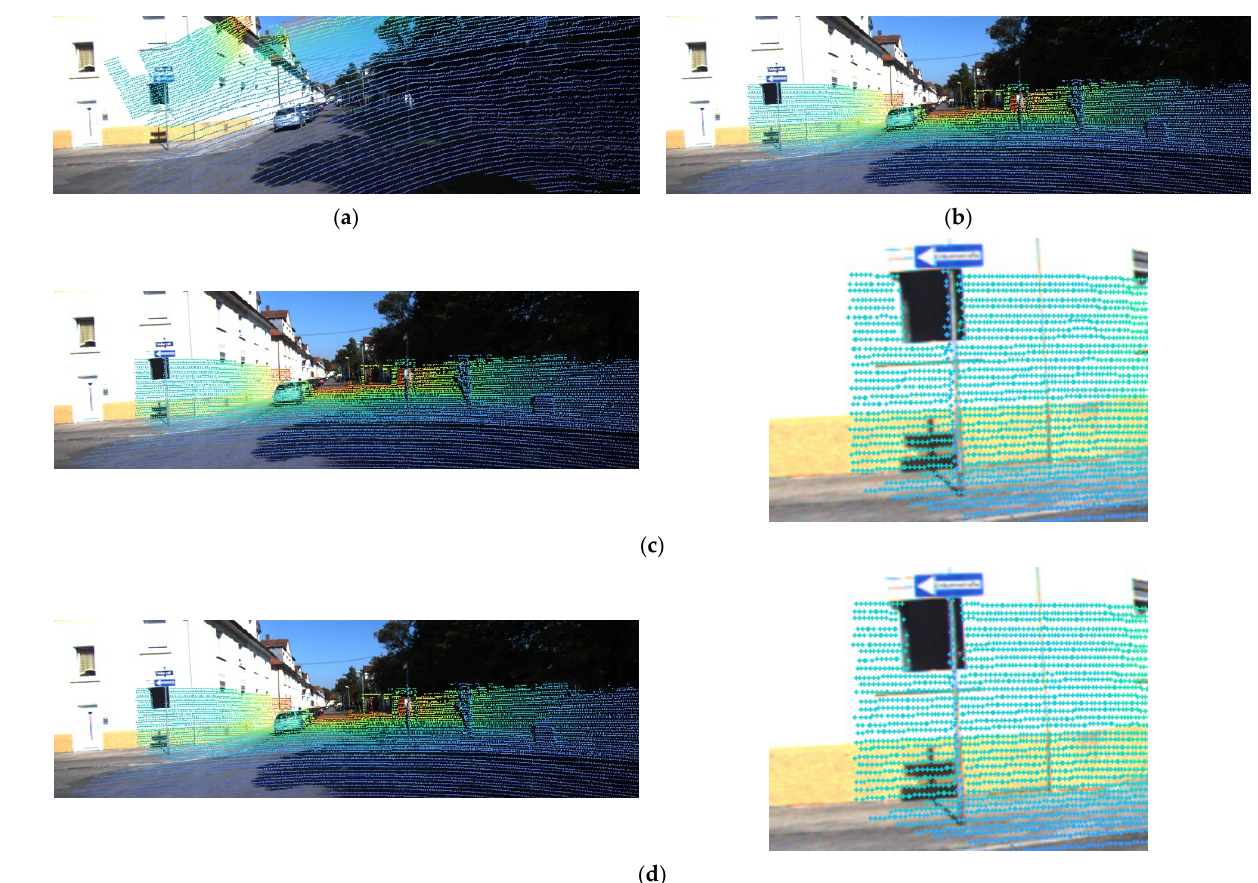
Figure 3. Results of applying the proposed method to a test frame of the KITTI dataset. ( a ) Trans- formation by randomly sampled deviations. ( b ) Transformation by given calibrated parameters. ( c ) Transformation by RT 1 inferred from Net1. ( d ) Transformation by RT online obtained from iterative refinement by five networks.